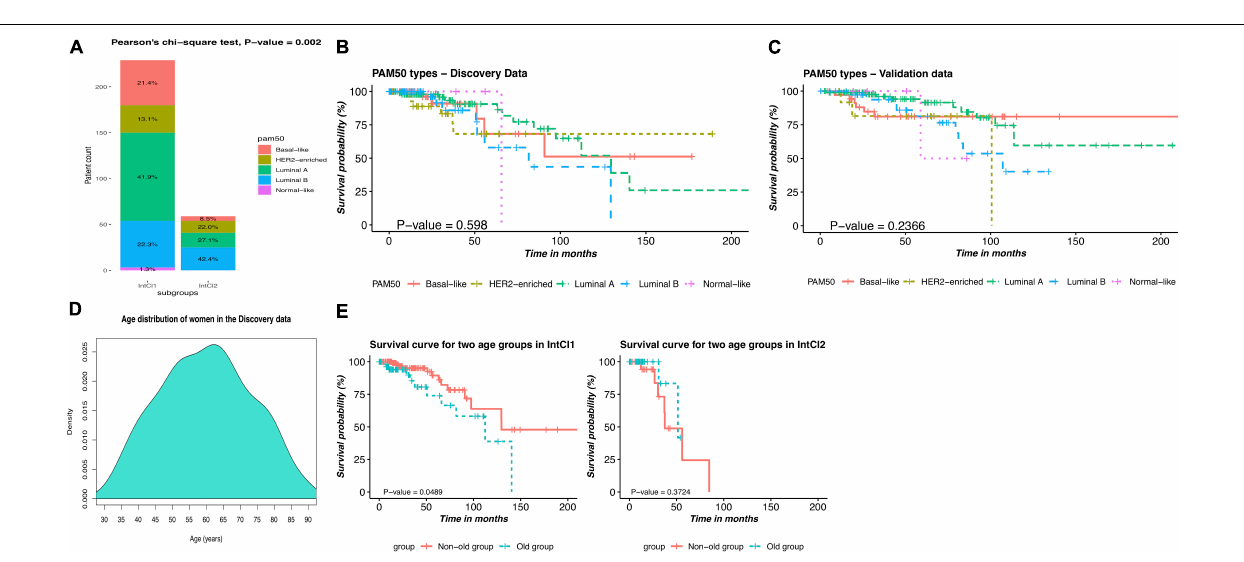
FIGURE 5 | Comparison of the PAM50 subtypes and the integrative subtypes, and description of age-related risks of BRCA patients in each integrative subtype. (A) Distribution of the PAM50 intrinsic subtypes between the two IntCl. (B) Kaplan-Mayer survival curve for the PAM50 labels in the discovery data. (C) Kaplan-Mayer survival curve for the PAM50 labels in the validation data. (D) Age distribution of women in the discovery data. (E) Kaplan-Meier survival curves of patients in two age groups in the identified